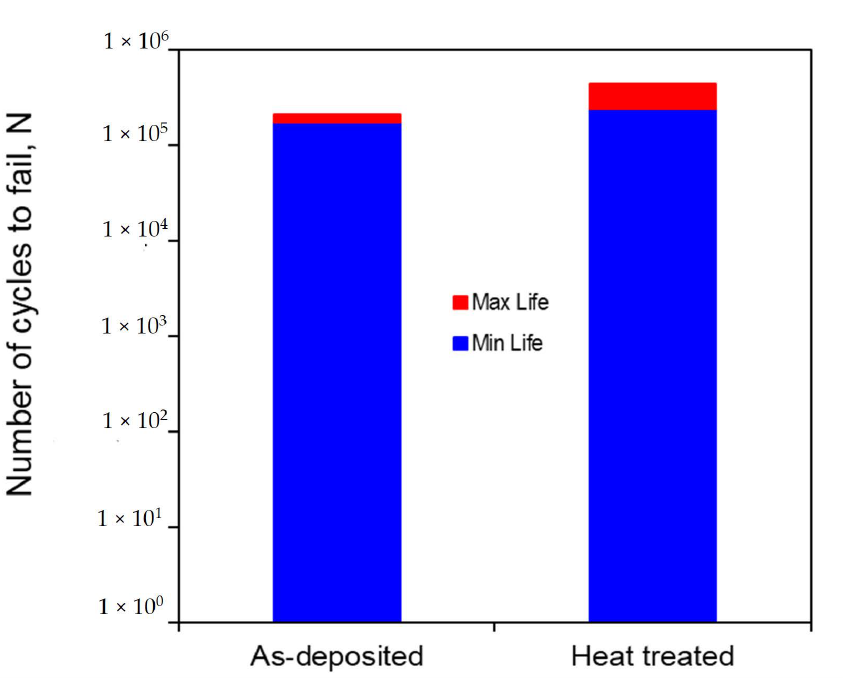
Figure 6. A comparison of the corrosion fatigue life between as-deposited and heat-treated at 300 ◦ C of the AA7075 cold spray coated AZ31b Mg alloy.